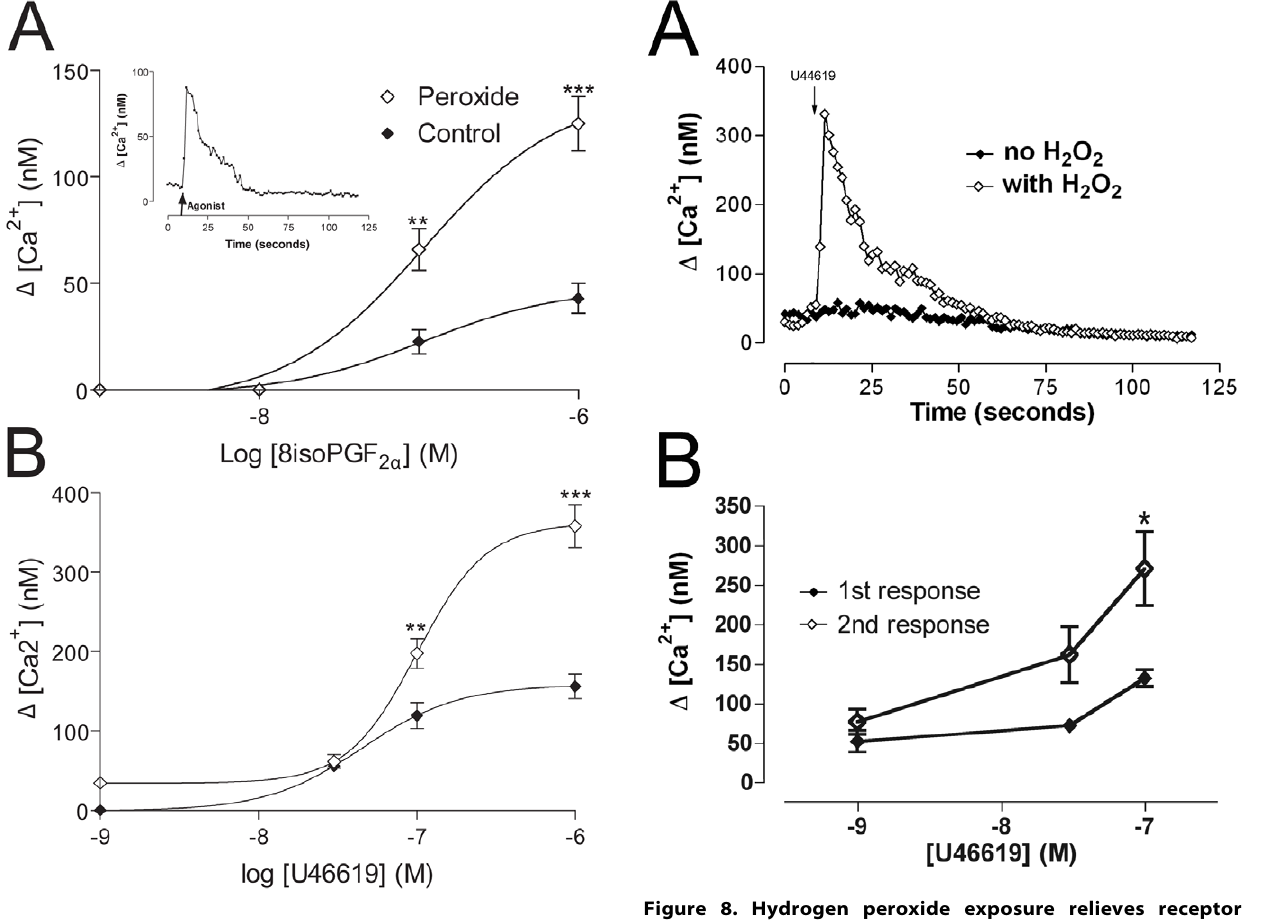
Figure 7. Concentration-response effect of thromboxane mimetic U44619 and 8-iso PGF 2 a on calcium flux in HEK293 cells stably expressing HA-TP b . HEK293 cells were loaded with FuraRed (20 m M) for 30 minutes at 37 u C. Cell visualization was performed using a Zeiss Axiovert 200 microscope and data processed using Volocity software (Improvision). Cytosolic calcium levels in response to stimulation were determined in the absence or presence of hydrogen peroxide (10 m M) and calculated as described under methods. Figure A inset represents a single trace following the addition of 8-iso PGF 2 a (nM). Following addition of agonist at the point indicated in the figure, a rapid increase in calcium concentration is observed ( , 100 nM) which is sustained for , 60 seconds. Similar response curves were generated for 8-iso PGF 2 a (Panel A) and U46619 (Panel B). Data represent the mean 6 SEM (n=7), ** P , 0.01, *** P , 0.001.